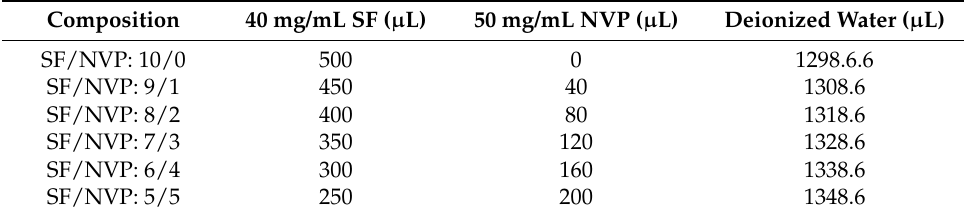
Table 1. Indicates the content of each component in the mixed